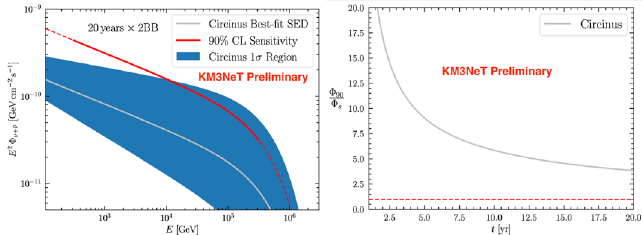
Figure 3. Left The integrated sensitivity compared with the theoretical 1 σ uncertainty band of the source (according to the analysis of [3]). The plot refers to 20 years of data taking for 2 Building Blocks. Right The ARCA sensitivity as a function of time. The detector is not able to discriminate the SBG scenario in the best-fit scenario. It can trace the upper limit of the expected